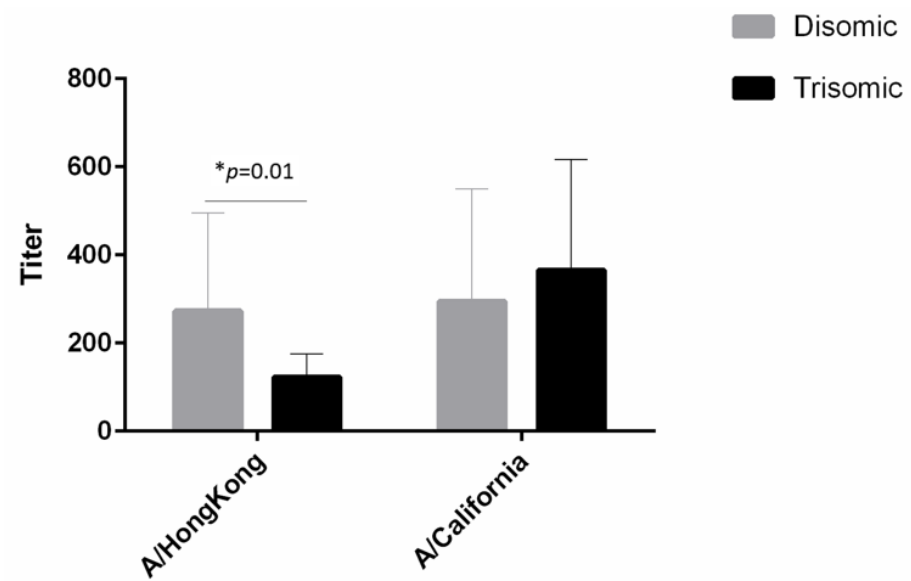
Figure 2. Antibody titers were evaluated using the hemagglutinin inhibition assay. Antibodies to Influenza A/Hong Kong from individuals with Trisomy 21 were significantly decreased compared to disomic individuals.